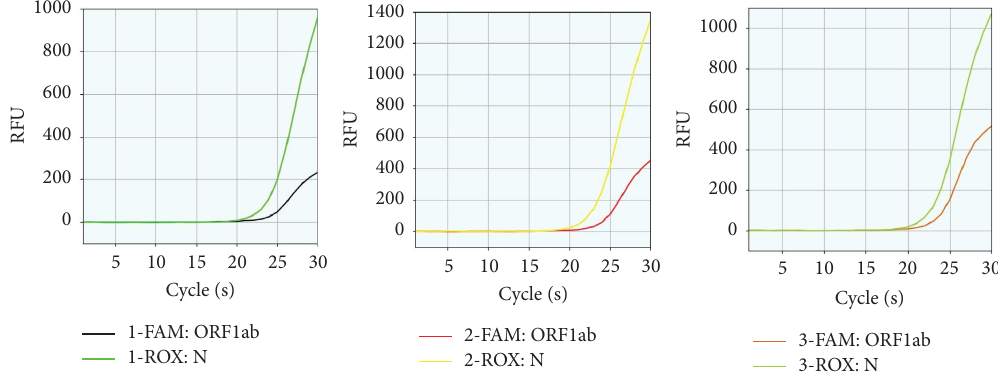
Figure 4: PCR amplifcation curve of Omicron variant sample with the concentration of 750 copies/mL.